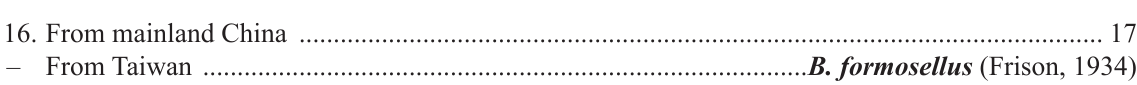
– 17. Hair of face entirely black, thorax anterior and posterior white bands with many black hairs – Hair of face with short grey hairs intermixed, thorax anterior and posterior white bands with few